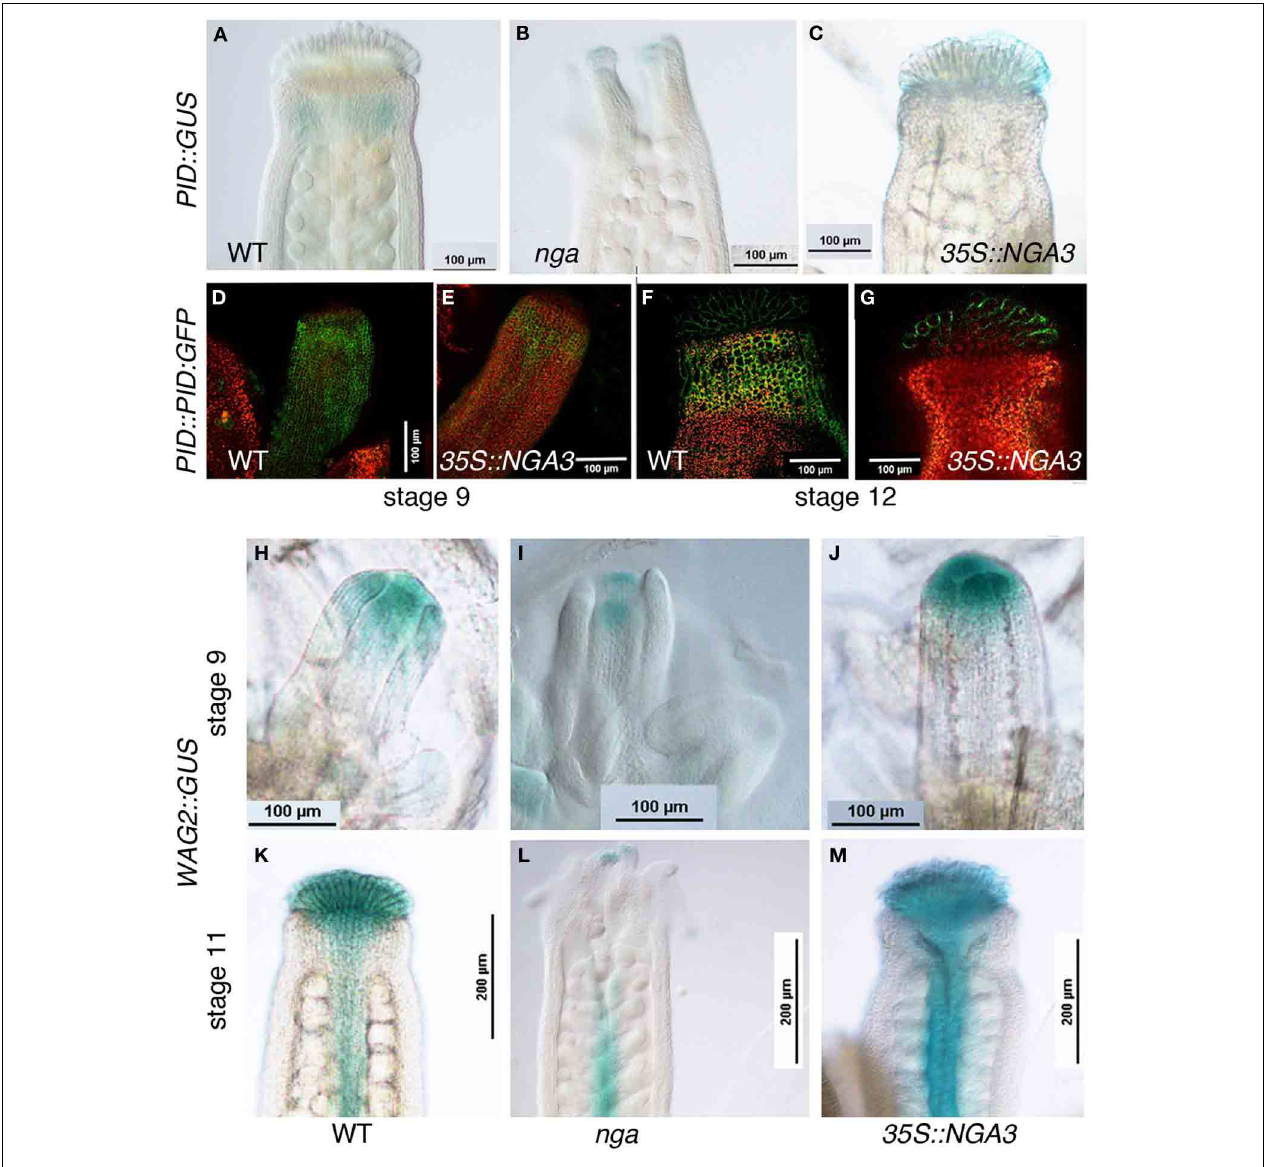
FIGURE 4 | Effect of NGA altered activity on the expression of protein kinases involved in the regulation of PIN subcellular polarization. (A–C) Histochemical detection of GUS activity driven by the PID promoter in wildtype (A) , nga quadruple mutants (B) and 35S::NGA3 apical region of stage 12 gynoecia (C) . (D–G) PID::PID:GFP expression in stage 9 wildtype